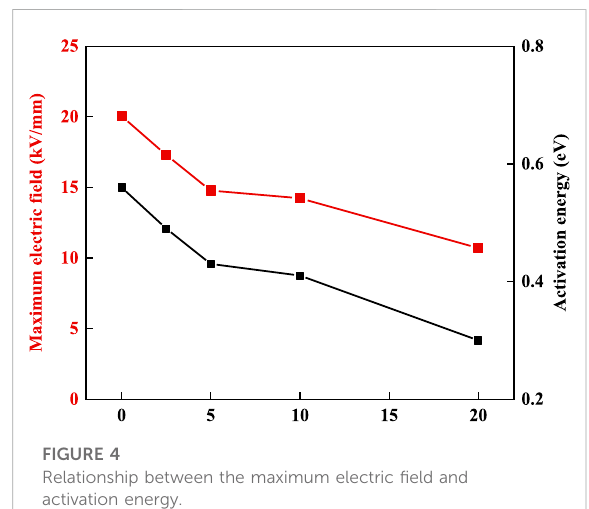
FIGURE 4 Relationship between the maximum electric fi eld and activation